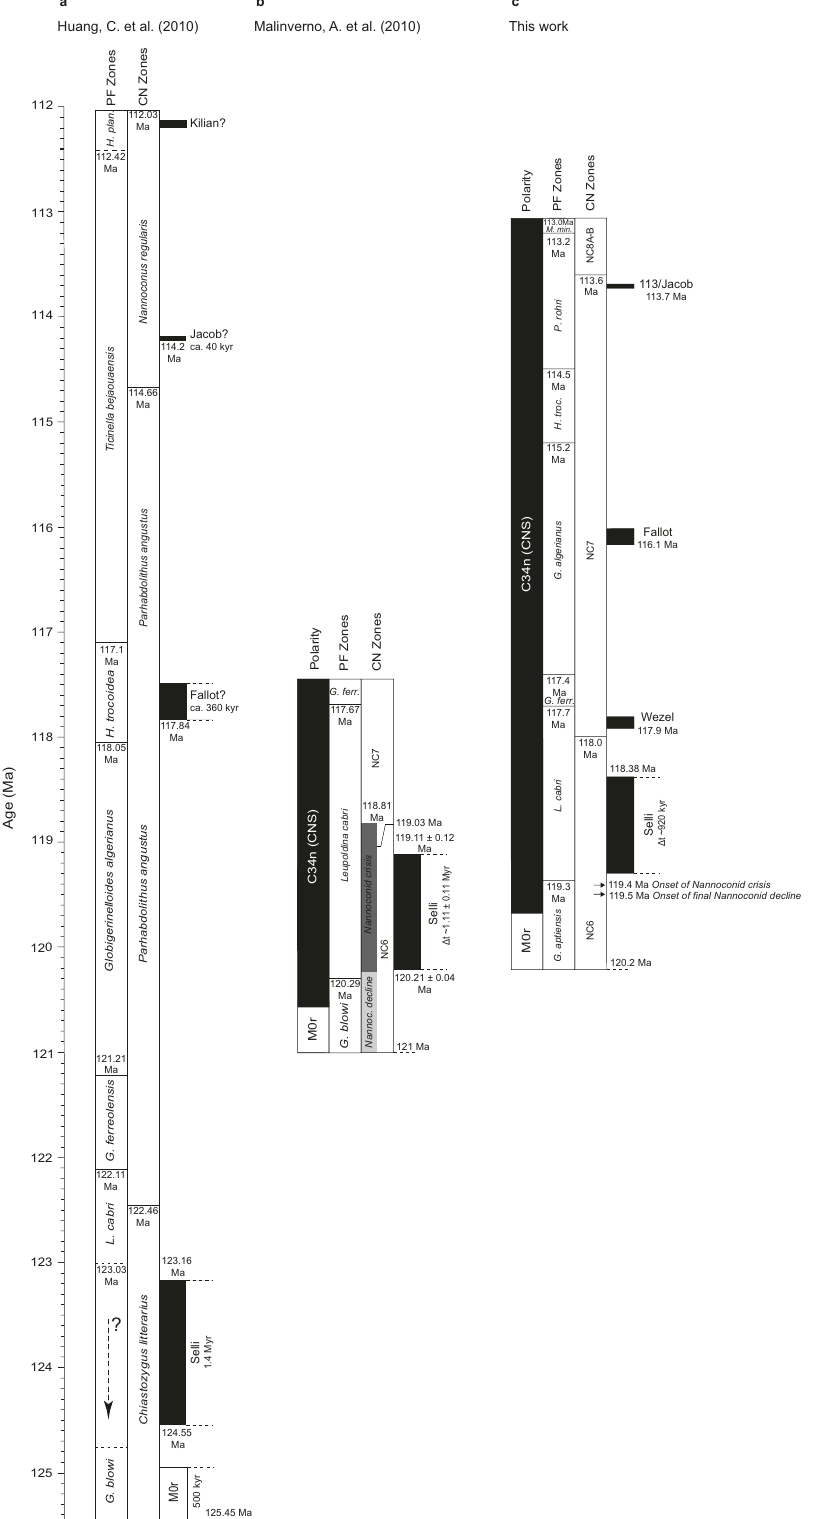
Fig. 5 Comparison with Aptian timescales. Stratigraphic correlation of a Huang et al. 21 ; b Malinverno et al. 24 ; c this work. The comparison tables indicate the magnetic polarity and planktonic foraminiferal and calcareous nannofossils zones. Stratigraphic extent of Selli Level equivalent sediments deposited during OAE 1a, Wezel Level, Fallot Level, 113/Jacob Level, and the Aptian – Albian boundary. The black arrows recorded decline and crisis of nannoconids. All stratigraphic scales are in age. H. Hedbergella, plan. planispira , G. Globigerinelloides L. Leupoldina, ferr. ferreolensis , Nannoc. Nannoconid , M. Microhedbergella , min. miniglobularis , P. Paraticinella .